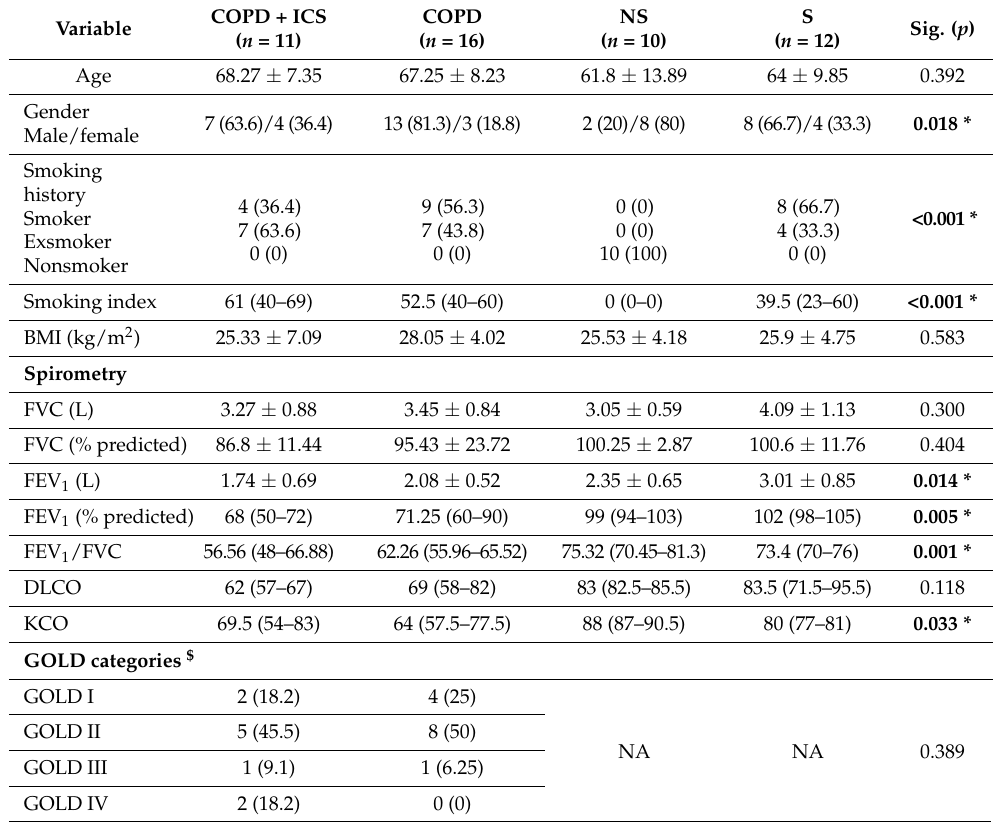
Table 1. The baseline characteristics of the studied